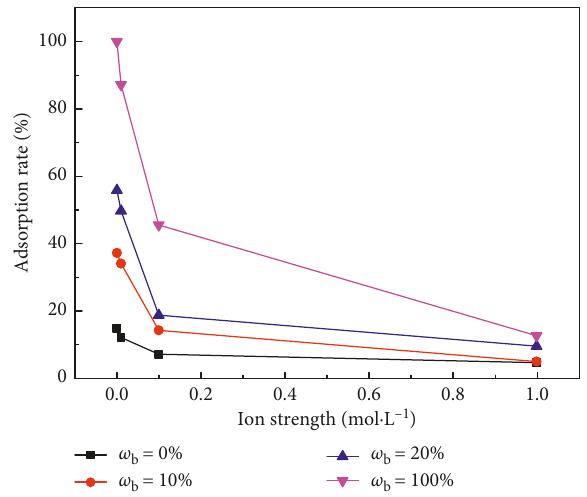
Figure 6: Influence of initial ion strength on Pb(II)